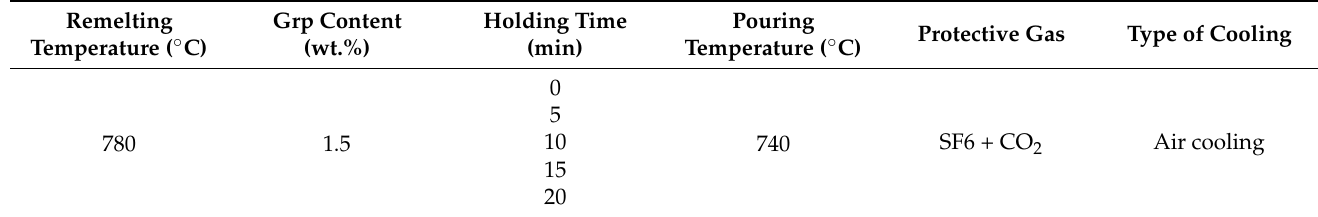
Table 2. Experiment parameters of the effect of holding time on Graphite/AZ91D composites. Remelting